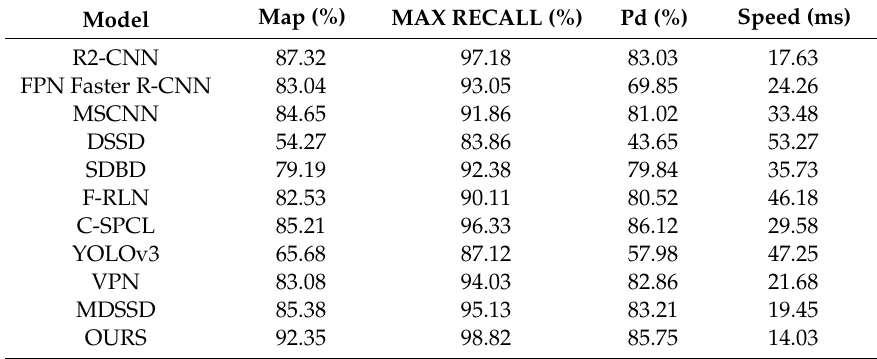
Table 4. Comparison of the object detection performance using the DOTA